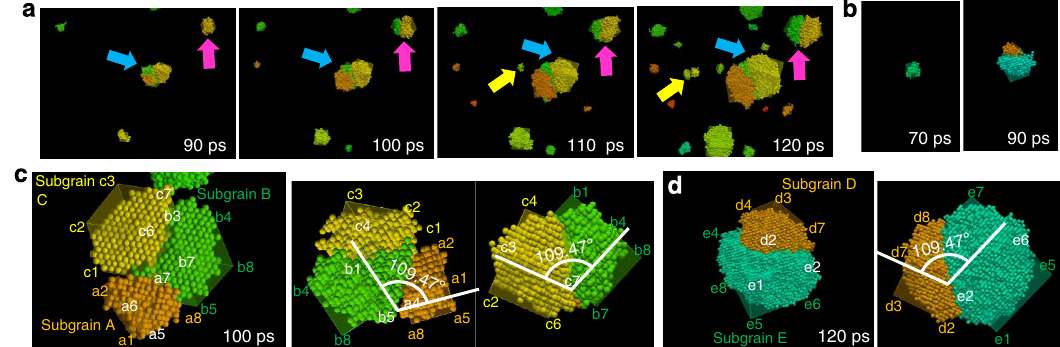
Fig. 5 Snapshots of atomic con fi guration showing the evolution of twin boundaries in grains. a , b Time series of snapshots showing the evolution of twin boundaries for a 0.58 T m and b 0.67 T m . c , d Enlarged views of grains with twin boundaries extracted from the calculation for c 0.58 T m and d 0.67 T m . Vertices of cubes indicating the disorientation angle of the grain relative to the coordination axis are labelled to clarify the positional